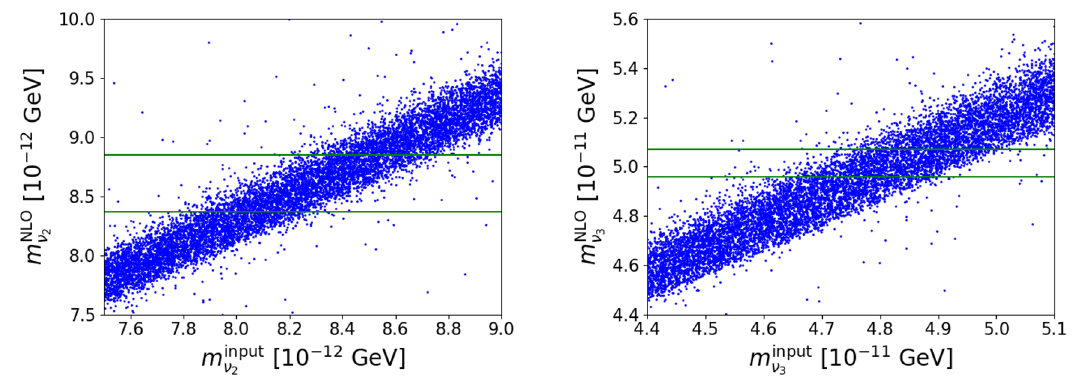
Figure 6 . Impact of one-loop corrections to scalar and fermion masses on the neutrino masses. We show the leading order (input) neutrino mass entering the Casas-Ibarra prescription against the mass obtained from SPheno when taking into account one-loop corrections to the scalar and fermion masses as discussed in sections 3.1 and